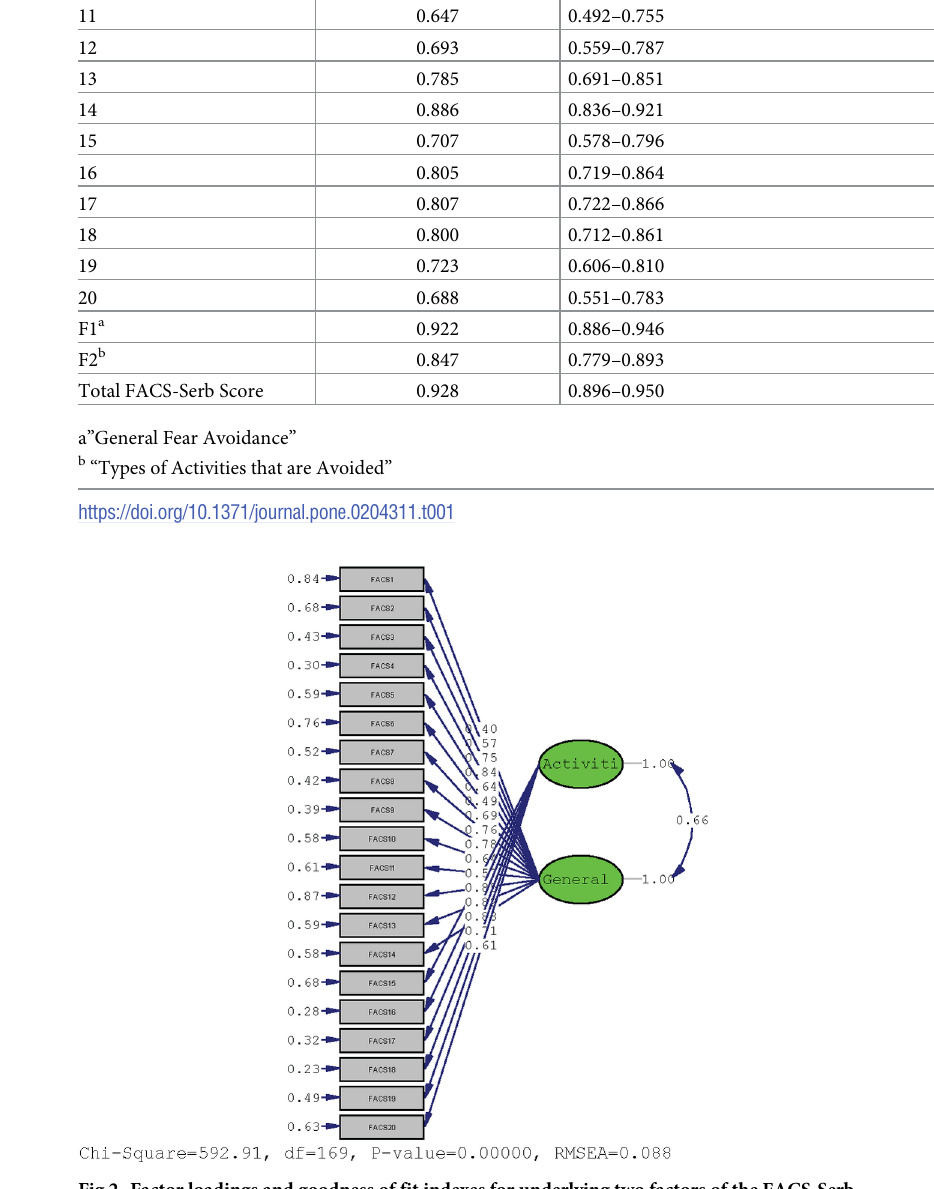
Fig 2. Factor loadings and goodness of fit indexes for underlying two factors of the FACS-Serb.